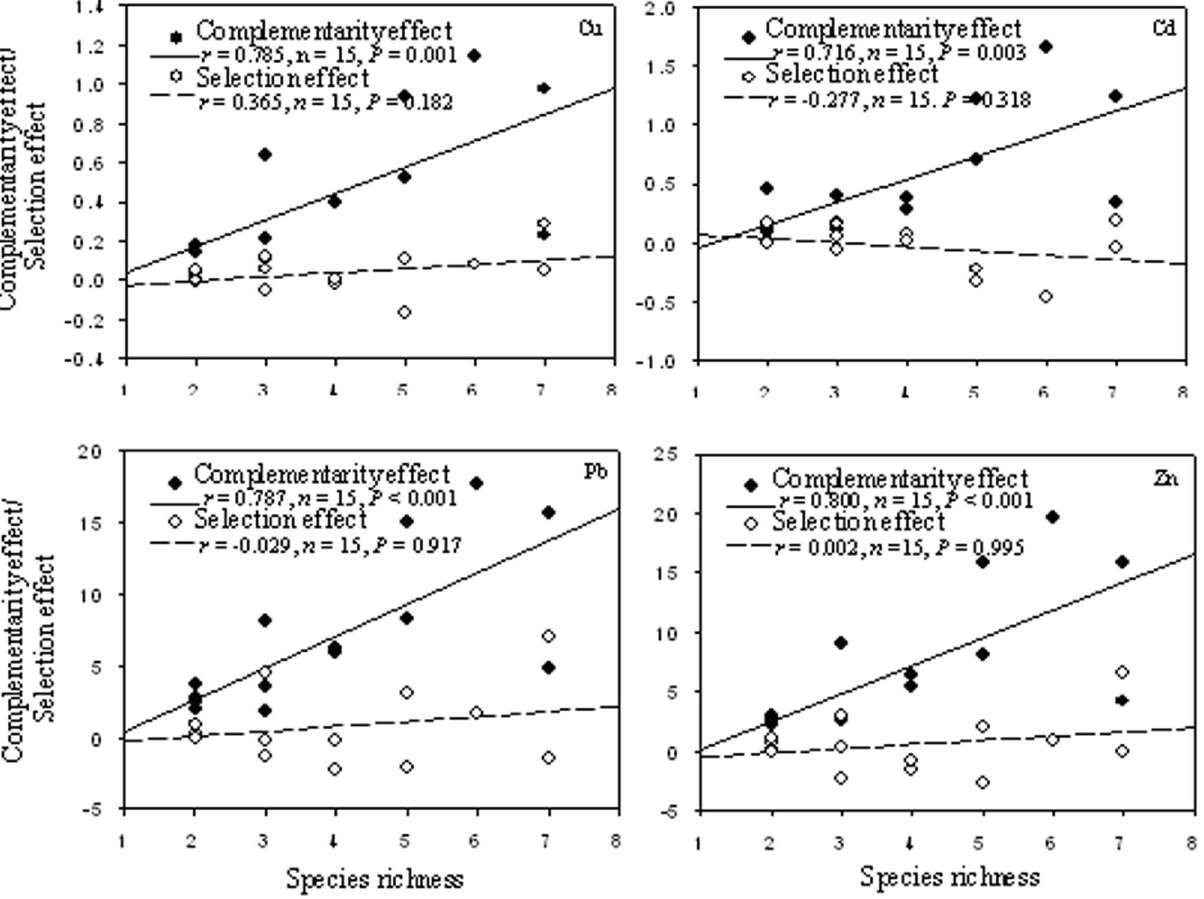
Figure 3. The dependence of the complementarity/selection effect on the actual species richness in the experimental plant communities. a) Cu, b) Cd, c) Pb and d) Zn. The relevant Spearman’s correlation coefficient and P -value are shown in each panel. doi:10.1371/journal.pone.0093733.g003 PLOS ONE |